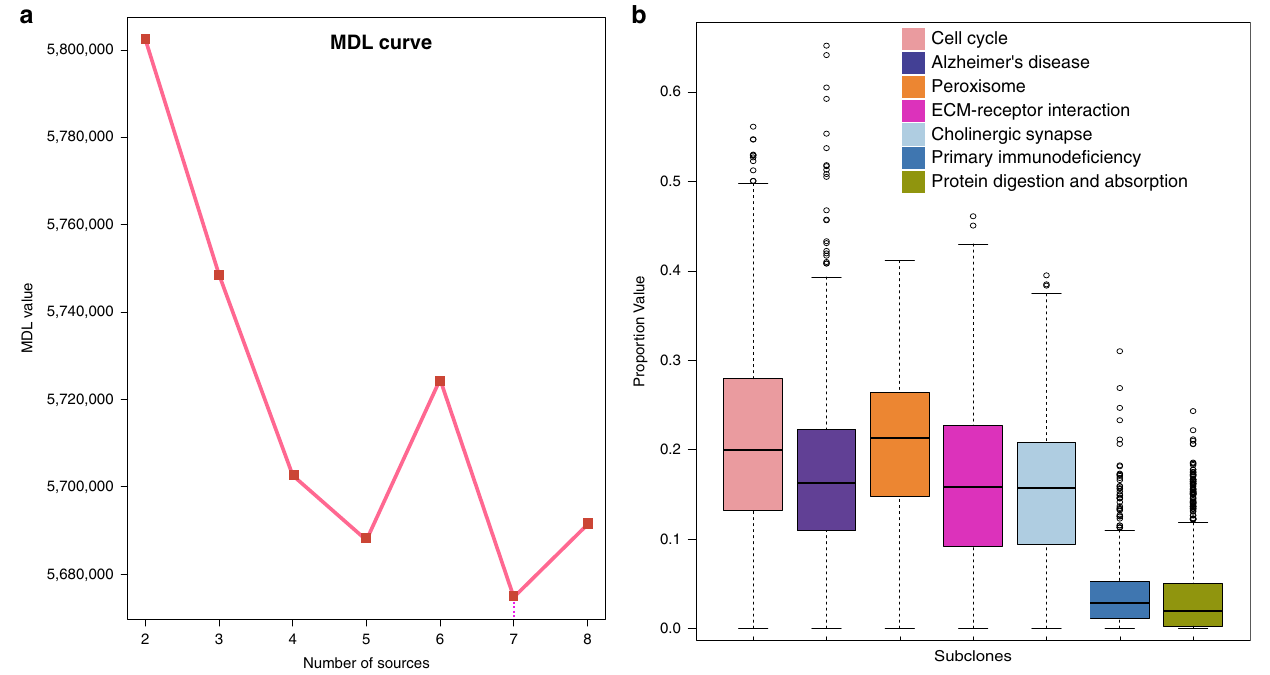
Fig. 3 Genomic subclone decomposed by the CAM method. a Minimum description length (MDL) curve for the gene expression decomposition based on the CAM method. b Proportional representation of genomic subclone fractions ( n = 660). In the boxplot, centre line represents median; box limits indicate upper and lower quartiles; whiskers represent 1.5 × interquartile range and points are outliers. Source data are provided as a Source data fi le.